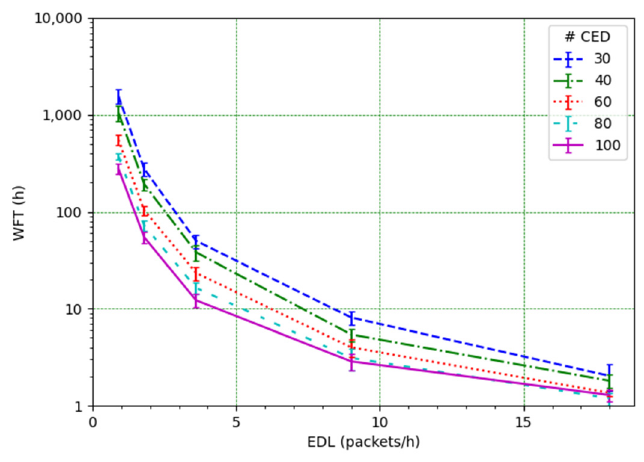
Figure 9. Mean and standard deviation of WFT as a function of EDL, for several numbers of CEDs.